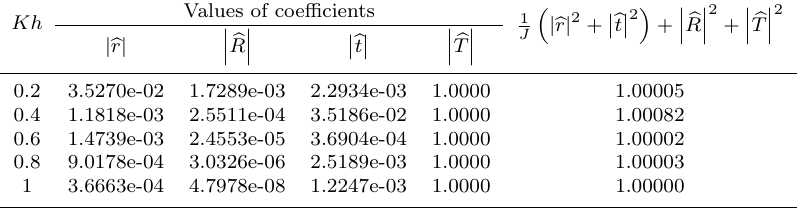
Table 3. Values of all coefficients for energy identity relation (6.2) Values of coefficients Kh